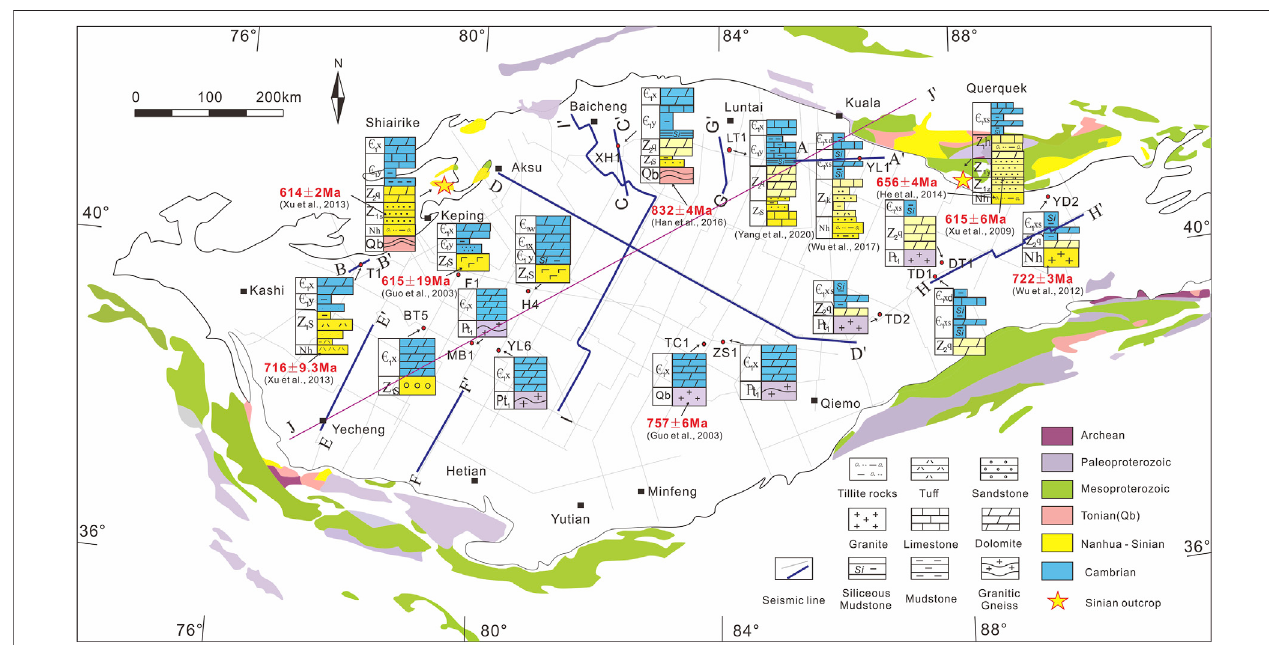
FIGURE 3 | Wells, seismic lines, and outcrops used in this